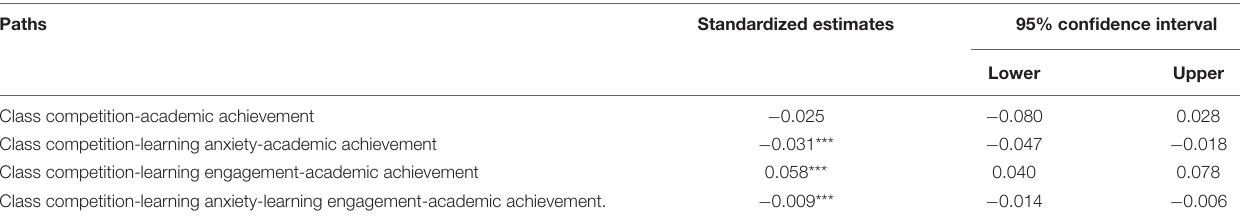
TABLE 2 | Bias-corrected bootstrap test on mediating